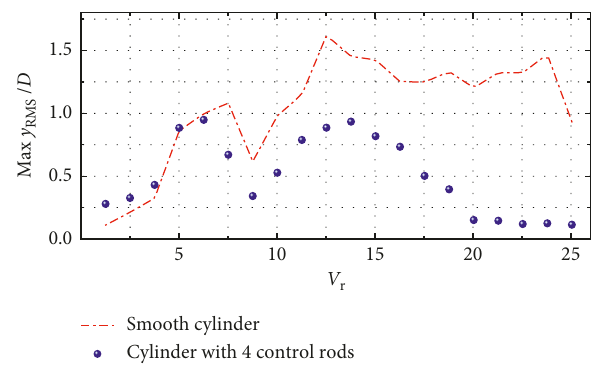
Figure 6: Maximum RMS dimensionless displacement of the main vertical flexible cylinder with control rods versus the reduced velocity.